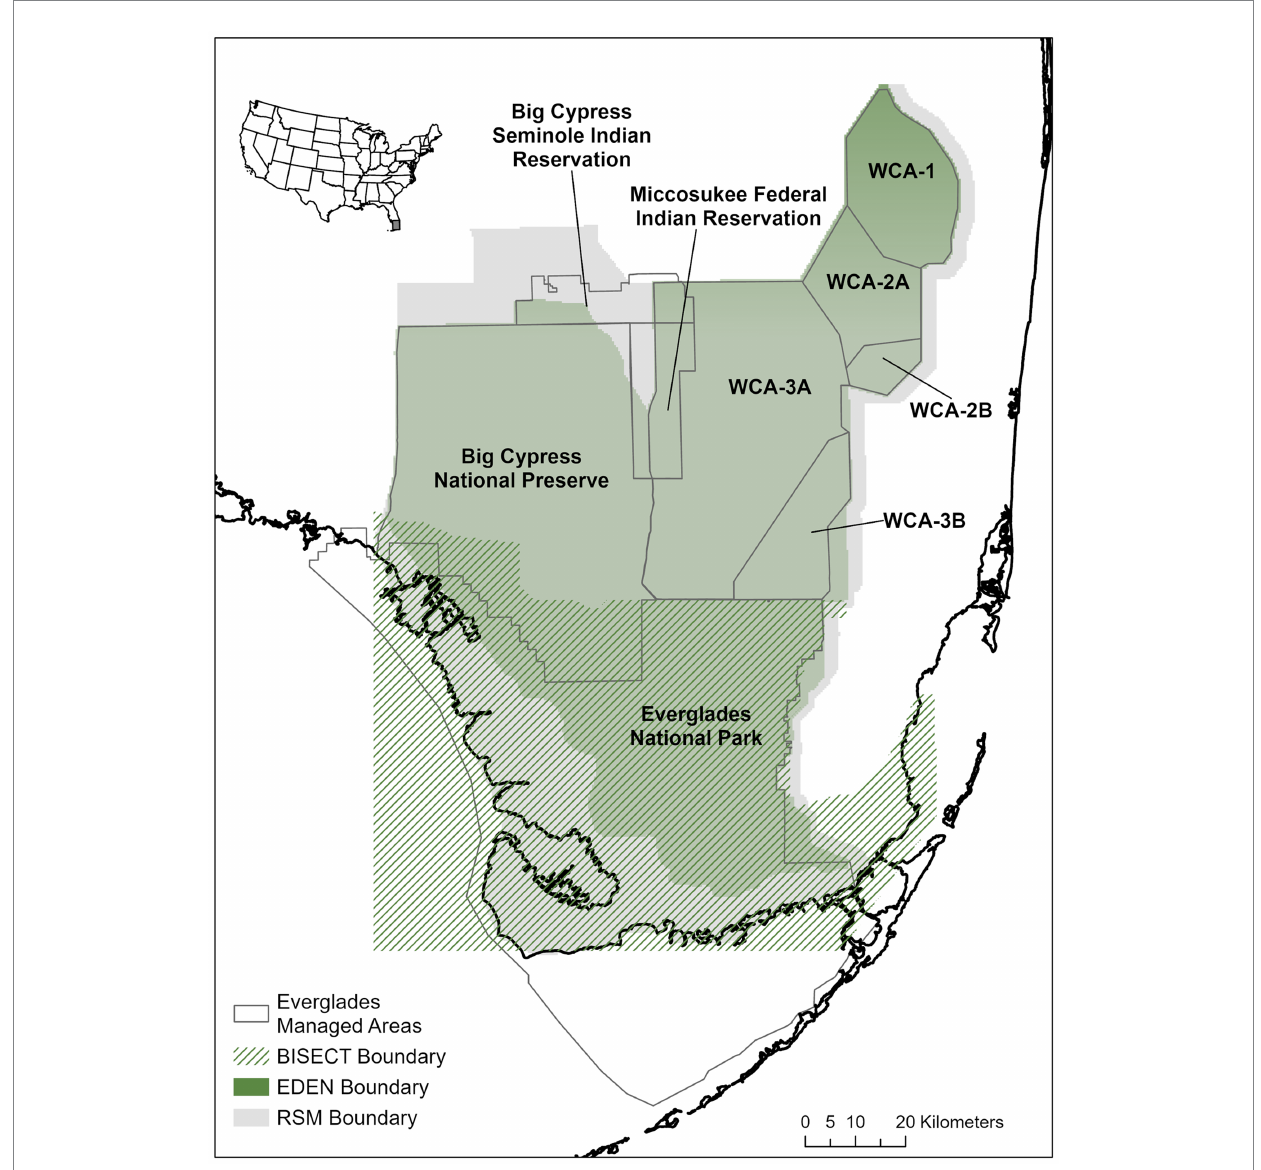
FIGURE 1 Spatial extent of the managed areas of the Everglades and the hydrologic models that the Everglades Vulnerability Analysis (EVA) can use as inputs. WCA = Water Conservation Area; BISECT = Biscayne and Southern Everglades Coastal Transport; EDEN = Everglades Depth Estimation Network; and RSM = Regional Simulation